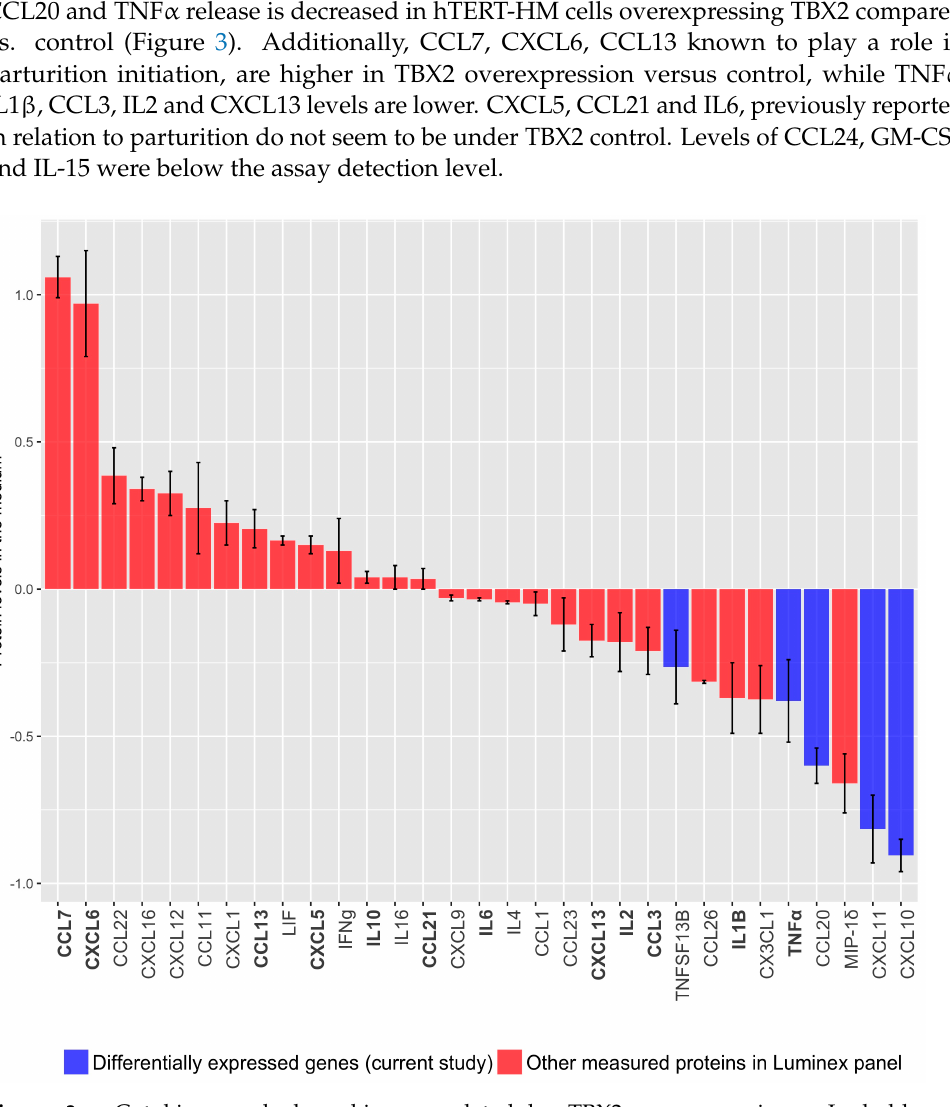
Figure 3. Cytokines and chemokines regulated by TBX2 overexpression. In bold: cytokines/chemokines involved in the initiation in parturition based on PubMed query. Represented are the cytokine and chemokine protein levels secreted from hTERT- HM cells in response to altered TBX2 expression and determined by Luminex assays. The bars are sorted from high to low levels of protein present in the culture medium. Protein levels in medium from mock-transduced control cells are set at zero. Error bars represent the standard error of the mean of two independent experimental observations. Purple bars: Differentially secreted proteins in hTERT-HM cells overexpressing TBX2 vs. control identified by microanalysis in the current study. Red bars: Proteins co-meas- ured because of their presence on the arrays used. Bold x -axis labels: previously reported in relation with parturition and identified by PubMed query (see Material and Methods). 3.2. TBX2 Inhibits Crucial Upstream Regulators in Preterm and Term Labour 3.2.1. TBX2 mRNA Expression in Human Preterm Myometrium Samples Microarray profiling of preterm no labour (PNL) and preterm spontaneous labour (PSL) myometrium samples used shows a statistically significant ( p = 0.015) upregulation of TBX2 mRNA in contractile myometrium (Figure 4a). QPCR analysis on an increased number of samples confirmed this finding ( p = 0.035) (Figure 4b).